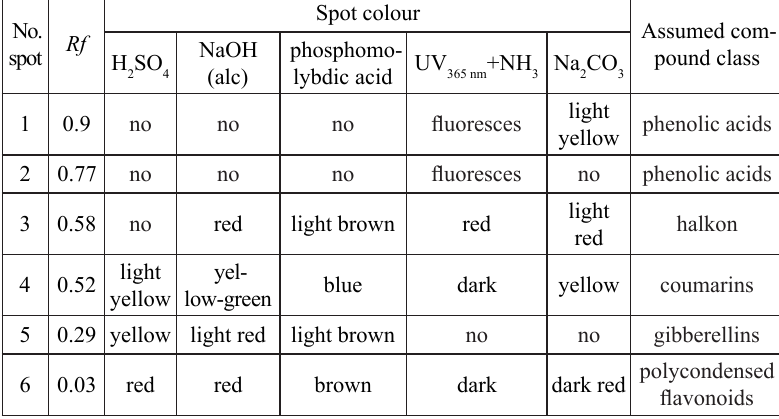
Thin layer chromatogram of ethyl acetate extract substances